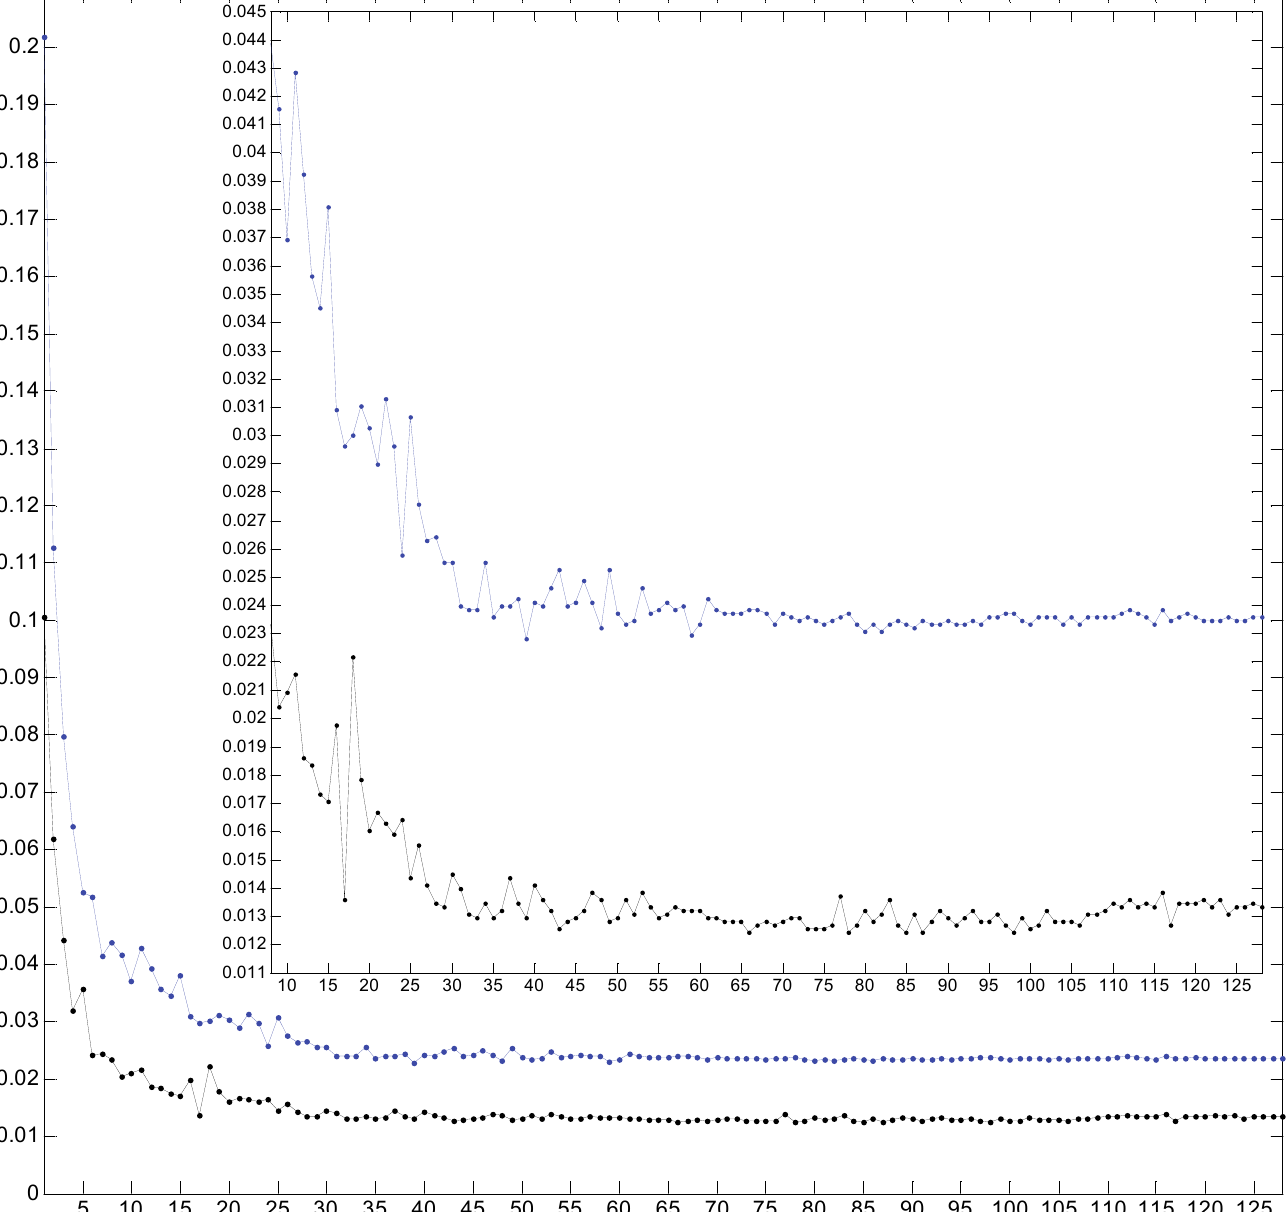
32 V along 128 epochs. The “worst” effect is 6